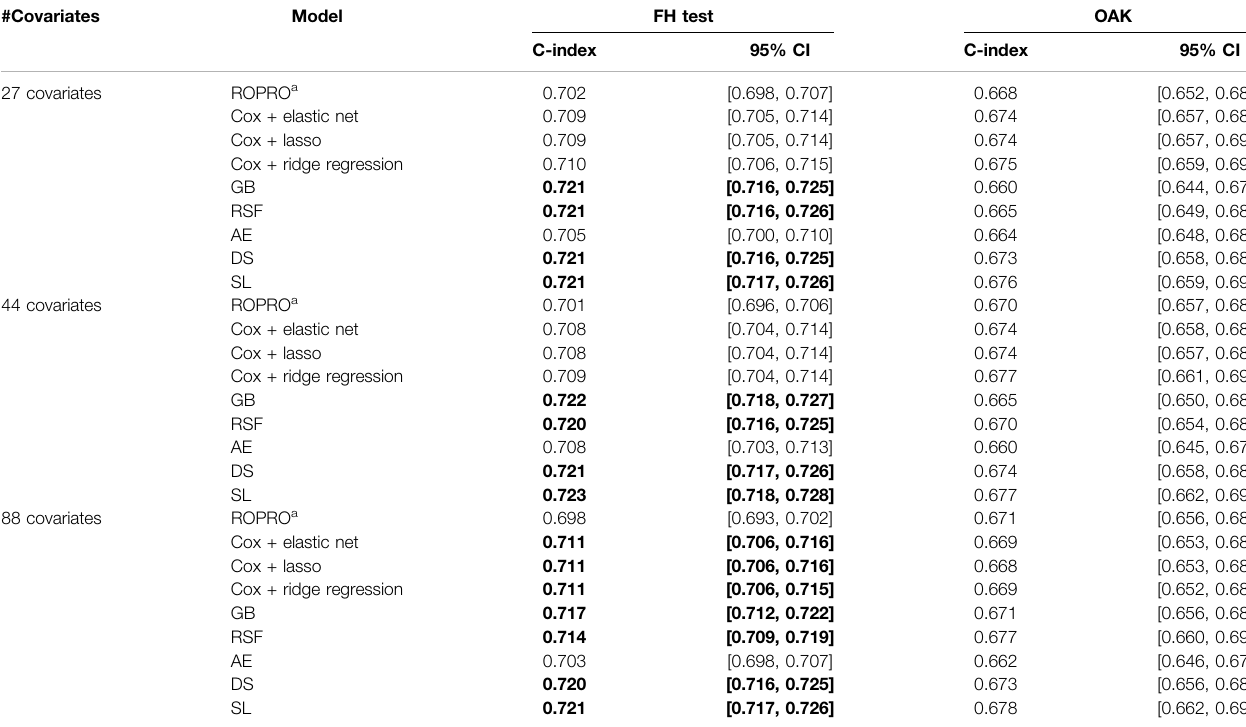
TABLE 4 | C-index and corresponding 95% con fi dence interval (CI) for all the models (ROPRO, regularized Cox models, Gradient Boosting (GB), Random Survival Forests (RSF), autoencoder (AE), DeepSurv (DS) and Super Learner (SL)) and covariate sets. Signi fi cant increases in C-index are in bold. Please refer to Individual Model Development section for the complete model